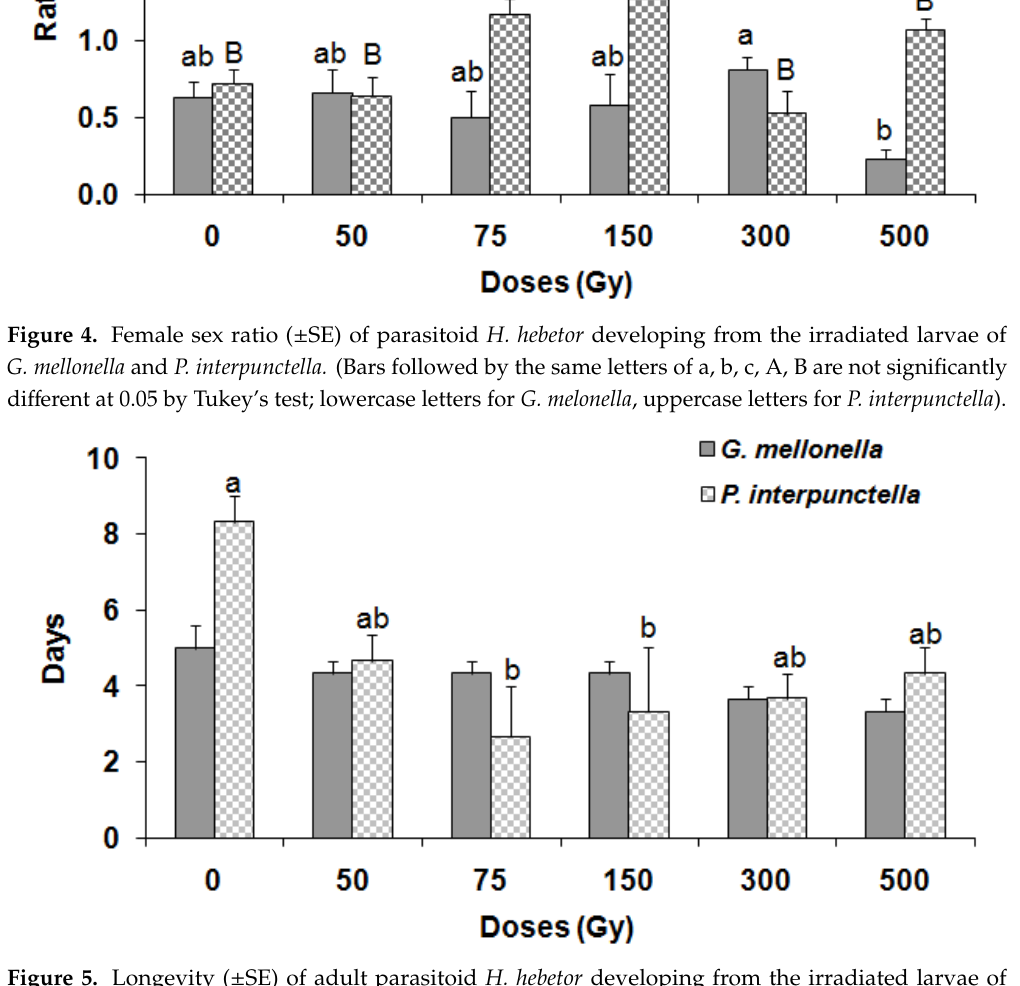
Figure 5. Longevity ( ± SE) of adult parasitoid H. hebetor developing from the irradiated larvae of G. mellonella and P. interpunctella. (Bars followed by the same letters of a, b are not significantly different at 0.05 by Tukey’s test for P. interpunctella ).